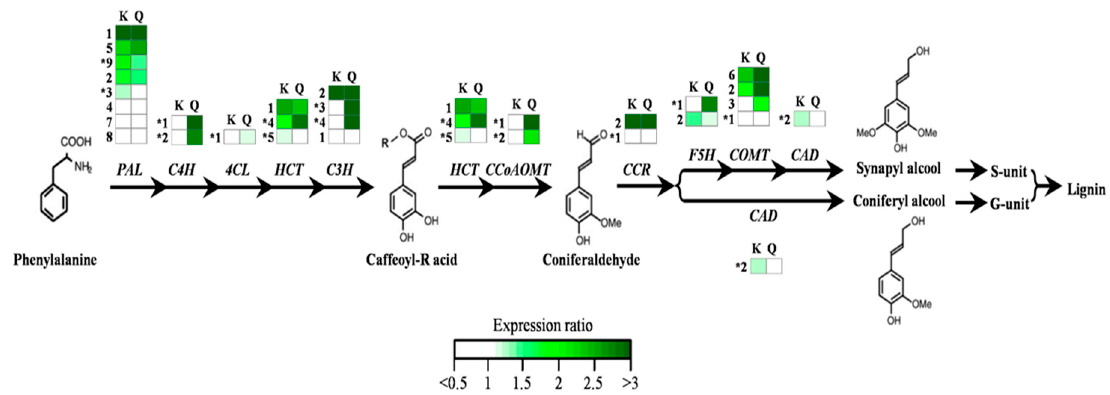
Figure 7. Impact of CBF overexpression on the relative expression of genes involved in the monolignol biosynthetic pathway. Transcript levels are relative to control plants, and were analyzed by RTqPCR. This pathway represents the main biosynthetic route toward the monolignols coniferyl and sinapyl alcohol, giving rise to G and S units, respectively, adapted from [32] (R = shikimic or quinic acid). The analyses included 17 bona fide genes (*) from the core vascular lignin toolbox involved in developmental lignification [31], and 14 additional isoforms showing induction in response to abiotic stresses in previous studies [4]. The green color in the heat maps illustrates induction of gene expression (ratio > 1) in transgenic CBF -OE plants, relative to control plants. Ratio values are provided in Table S1. Gene abbreviations are given according to [31]: PAL : phenylalanine ammonia lyase; C4H :